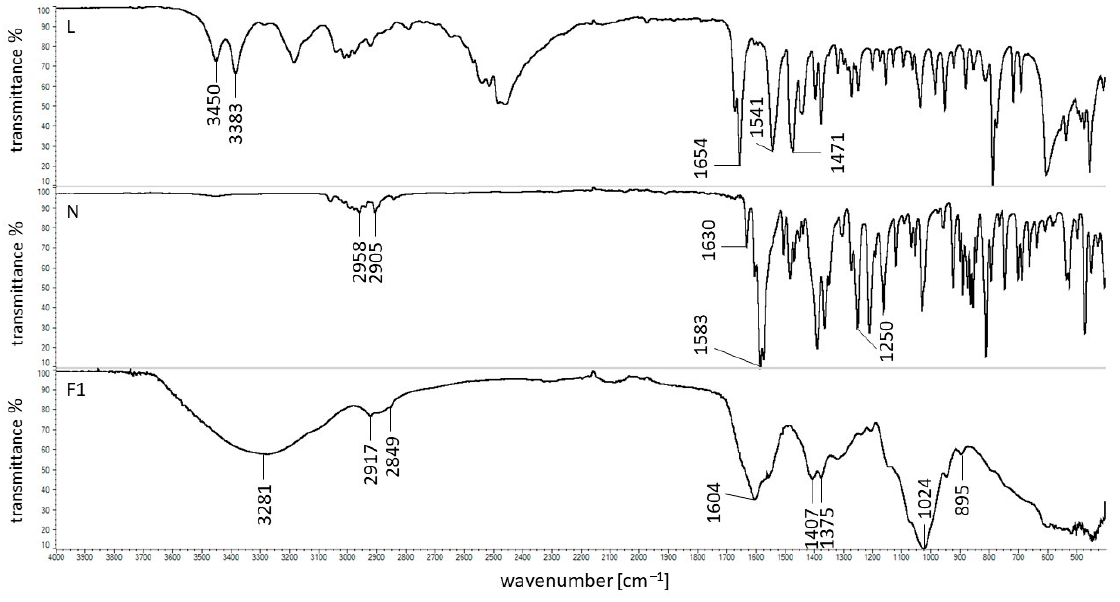
Figure 8. FTIR spectra of L, N and formulation F1.